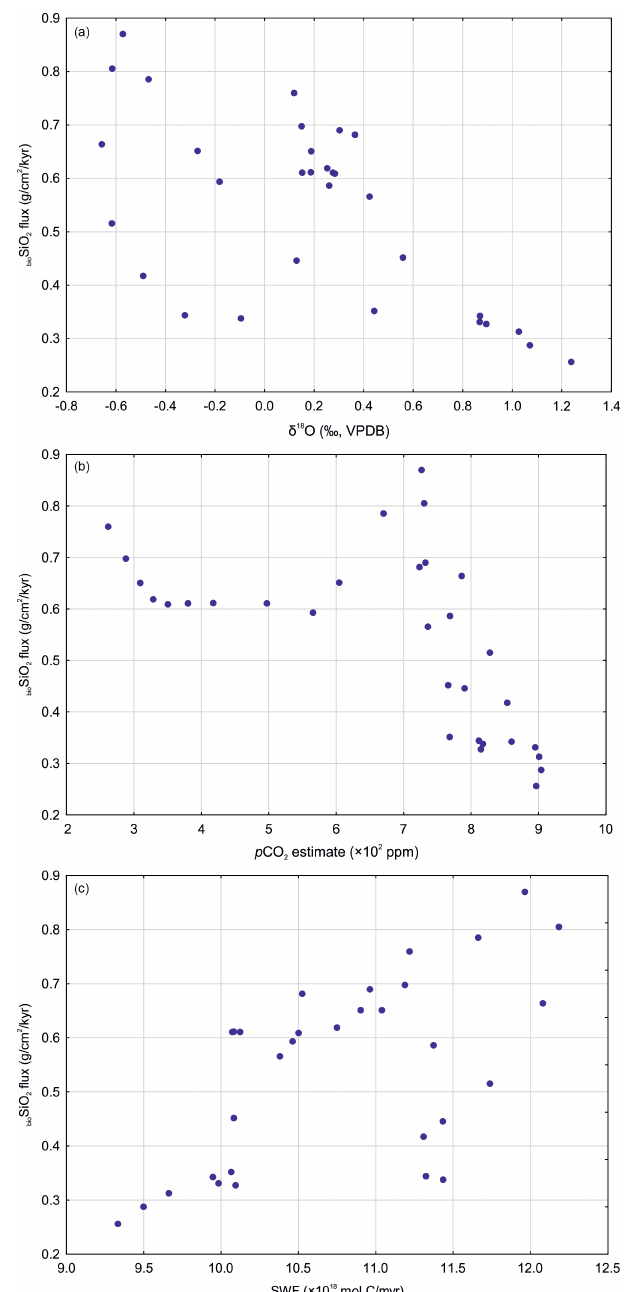
Figure 3. Correlation scatter plots for the three strongest statisti- cal relationships identified in the present study: biogenic silica flux vs. δ 18 O (a) , p CO 2 (b) , and silicate weathering flux (c) . Abbrevi- ations: bio SiO 2 – biogenic silica; SWF – silicate weathering flux. Data sources indicated in the